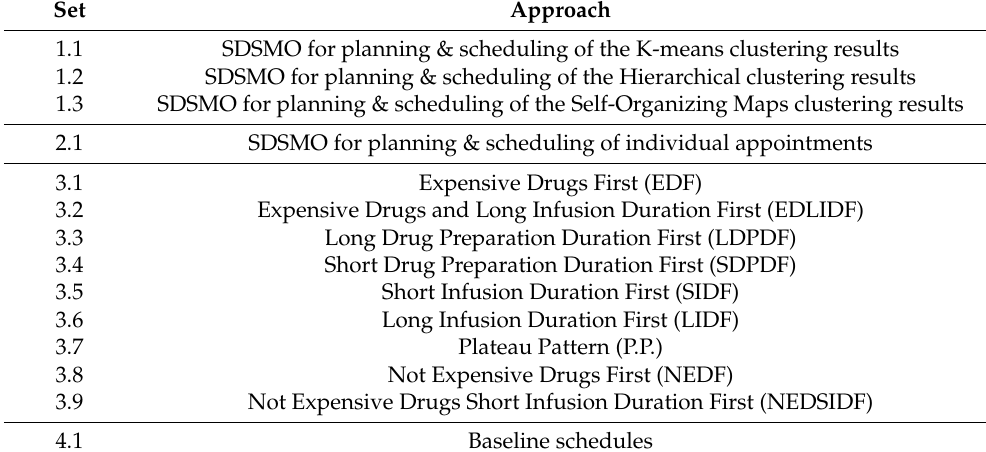
Table 4. Experiments sets.